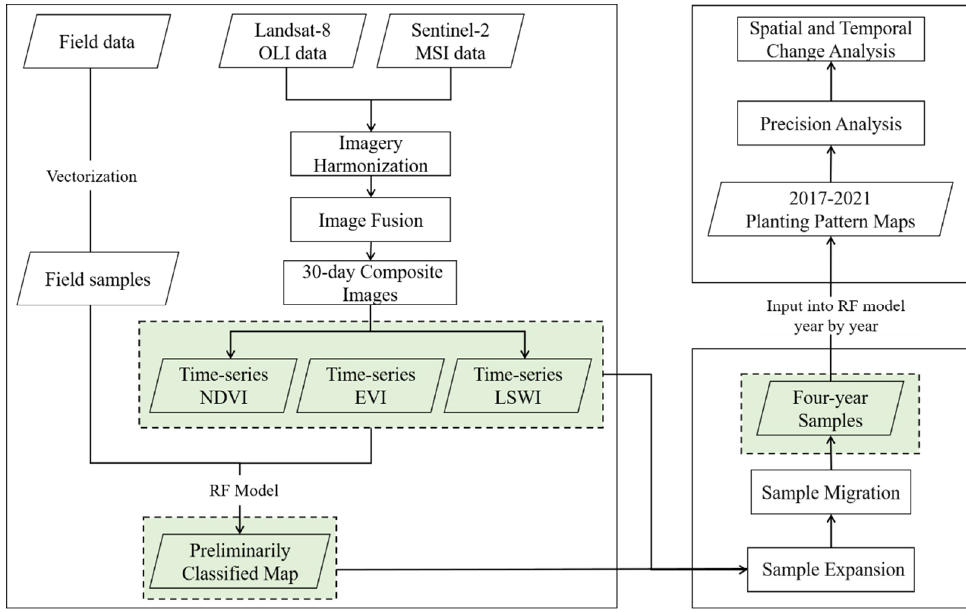
Figure 4. Flow chart of planting pattern mapping.